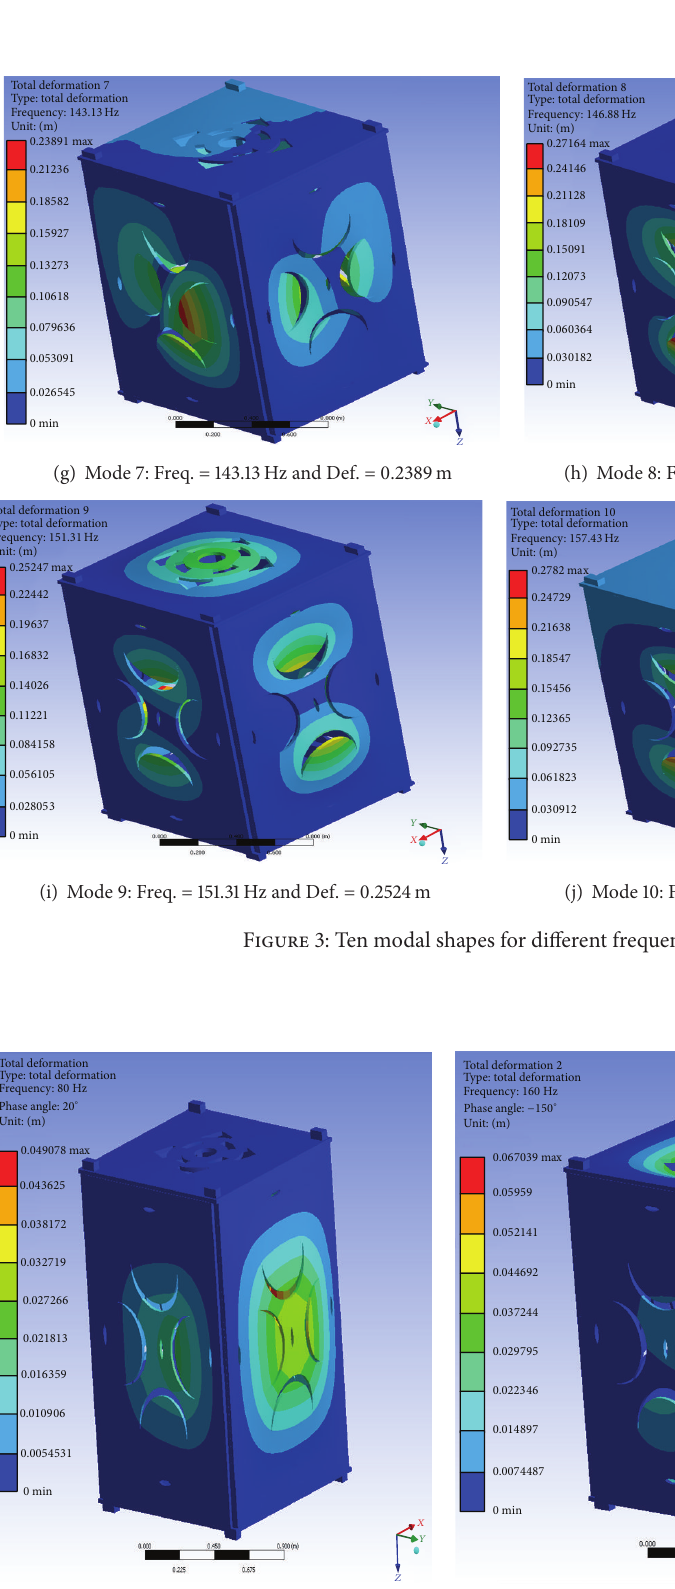
Figure 4: Deformation